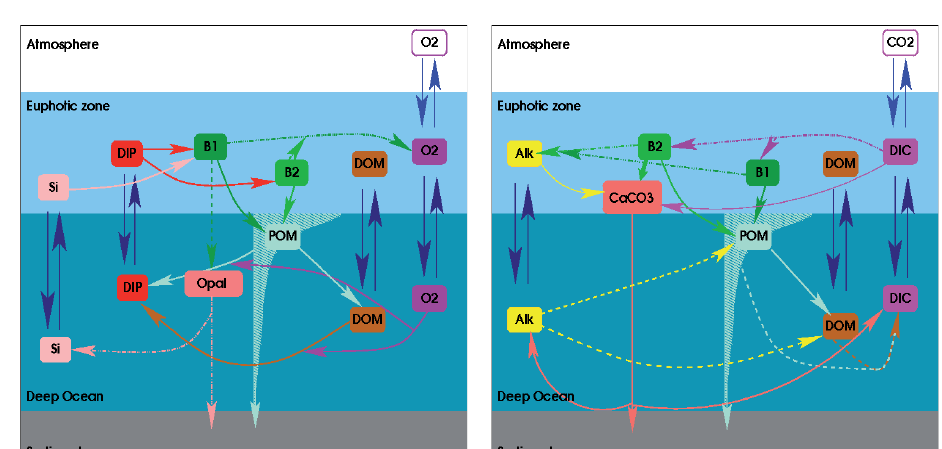
Fig. 5 Schematic representation of the main processes described in the LOCH model (Mouchet, 2010). The left panel focuses on purely biological processes, while the right panel shows the processes affecting the ocean carbon cycle. Up and down blue arrows represent transport processes (advection, diffusion, etc). Transported variables include dissolved inorganic carbon (DIC), alkalinity (Alk), dissolved inorganic phosphorus (DIP), dissolved organic matter (DOM), oxygen (O 2 ) and silica (Si). At the air-sea interface CO 2 and O 2 are exchanged with the atmosphere. B1 stands for opal building phytoplankton biomass and B2 represents the biomass of phytoplankton not relying on silica for growth (please note the inversion of B1 and B2 boxes between panels). POM decays at depth either as DOM or DIP. The flux of POM is governed following a power law function of the depth. Opal dissolves while sinking to the bottom. Calcareous shells (CaCO 3 ) reach the deepest layer where chemical conditions drive their dissolution or preservation. Fluxes to sediments, where permanent preservation prevails in this version, are also represented. Rivers (not illustrated) carry Si, DOM, DIC and Alk to the